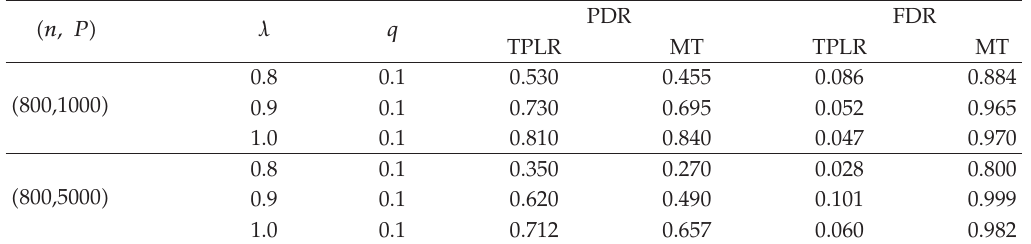
Table 4: The simulated average PDR and FDR under Model 3: two-locus threshold interaction e ff ects.